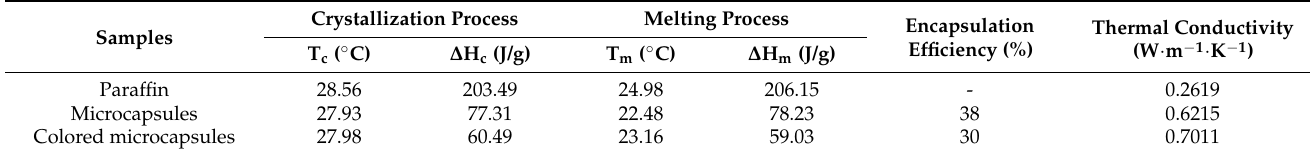
Table 4. Phase change properties of pristine paraffin and the obtained microcapsules.